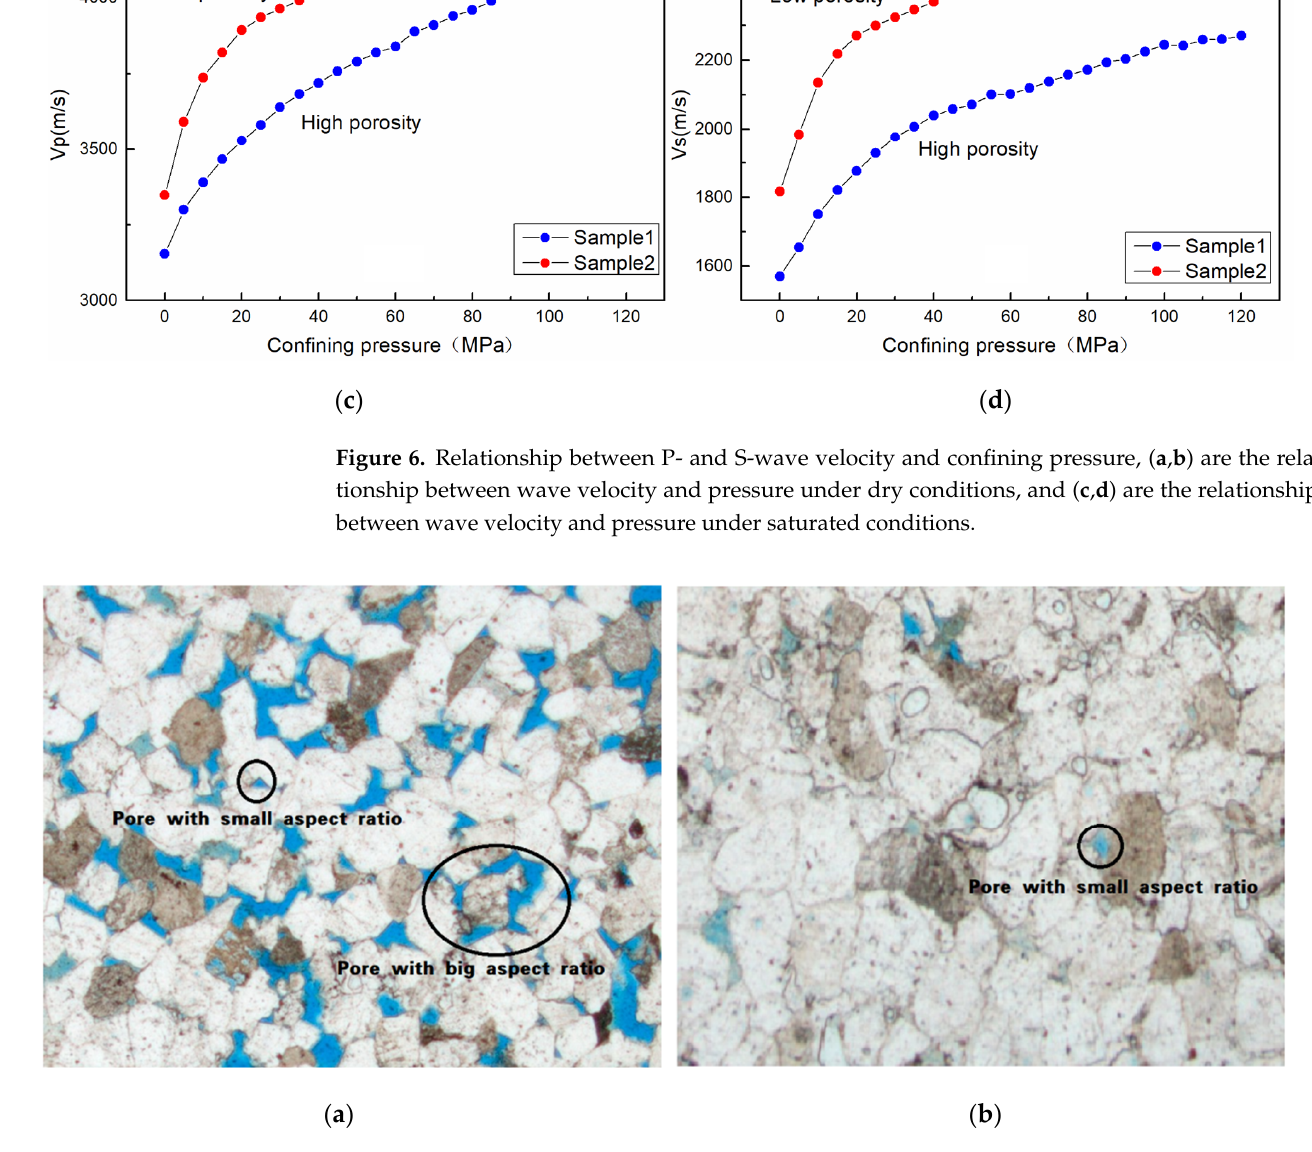
Figure 8. Cross-plot of temperature and P- and S-wave velocity. 4. Influence of Mineral Composition The composition of the rock skeleton also influences the relationship between velocity and pressure. Sample 3 and Sample 4 with small difference in porosity and pore structure but big differences in clay mineral content were selected for the analysis. The specific pa- rameters of these two samples are provided in Table 2. Figure 9 shows the cross-plot of the P- and S-wave velocity and confining pressure under dry and completely saturated condi- tions (test step of 5 MPa under room temperature). The trends of the two samples were identified to be similar under a low confining pressure, showing that the P- and S-wave velocity increased greatly with pressure. However, an obvious difference was found when pressure rose to 40–60 MPa. The P- and S-wave velocity of Sample 4 with low clay content gradually slowed down with the increase in pressure after the pressure exceeded 40–60 MPa, following which P-wave velocity increased by 16%. Sample 3 with a high clay content maintained a large range of increase, in which the P-wave velocity increased by more than 20%.